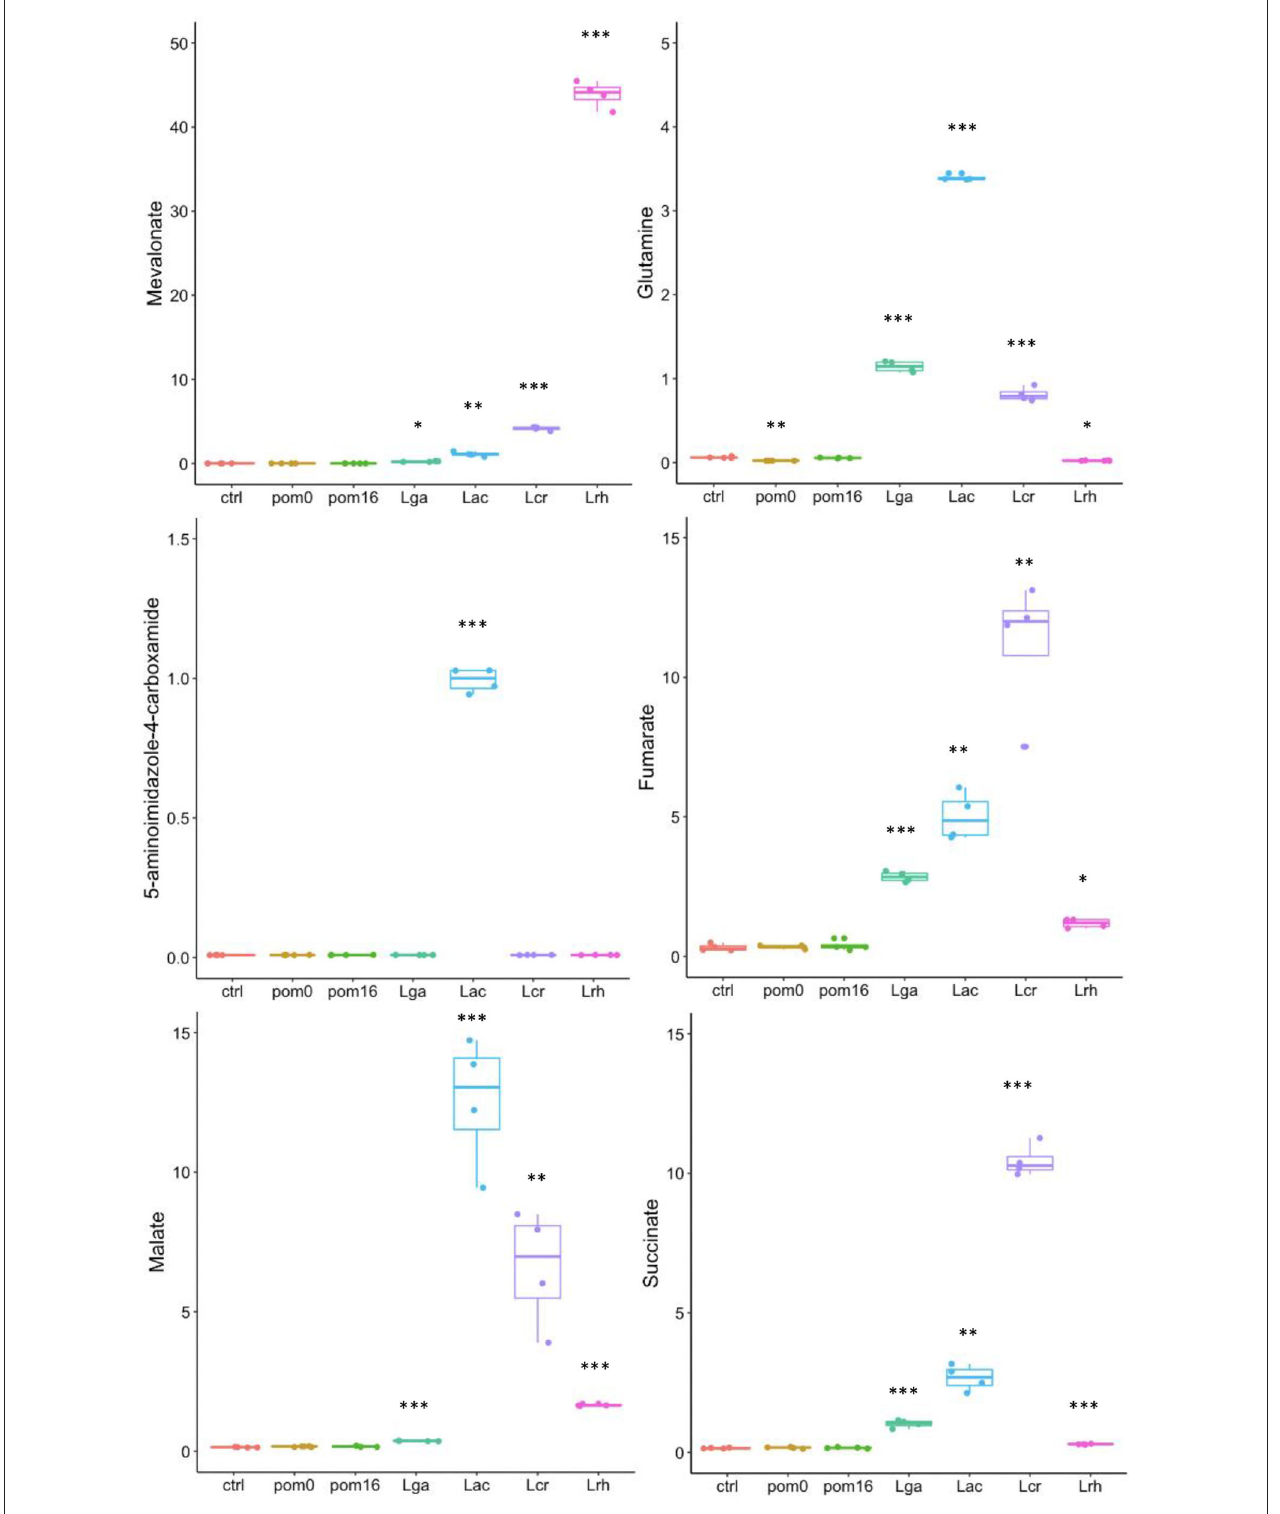
FIGURE 5 | Boxplots of specific metabolites. The data points are from the metabolomic data that were normalized and scaled to the median value for each compound. Boxplots for mevalonate, glutamine, 5-aminoimidazole-4-carboxamide, fumarate, malate, and succinate are shown. L. acidophilus NCFM (Lac), L. crispatus NCK1351 (Lcr) , L. gasseri NCK1342 (Lga), and L. rhamnosus GG (Lrh), SDM media alone (ctrl), SDM media with POM 400 µ g/ml at T0 (pom0) and T16 (pom16). p -values are indicated as follows: * p ≤ 0.05, ** p ≤ 0.005, *** p ≤ 0.0005, and they were determined by comparison to the control.